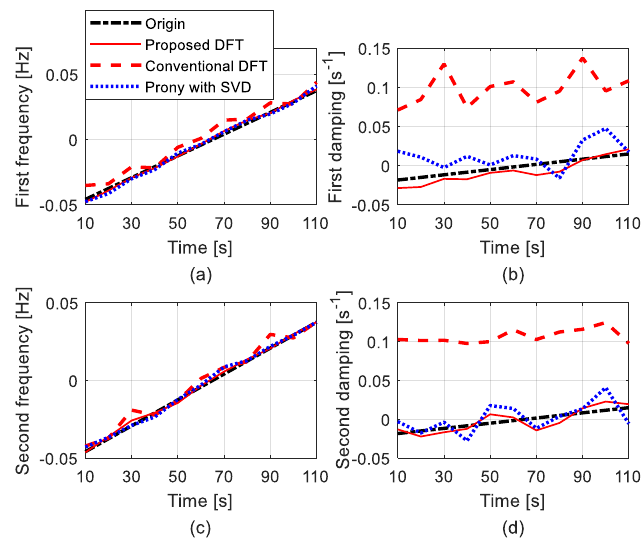
Figure 4. Estimated modal parameters in the simulation with a 50 dB SNR: ( a ) oscillation frequency of the first mode; ( b ) damping factor of the first mode; ( c ) oscillation frequency of the second mode; ( d ) damping factor of the second mode.